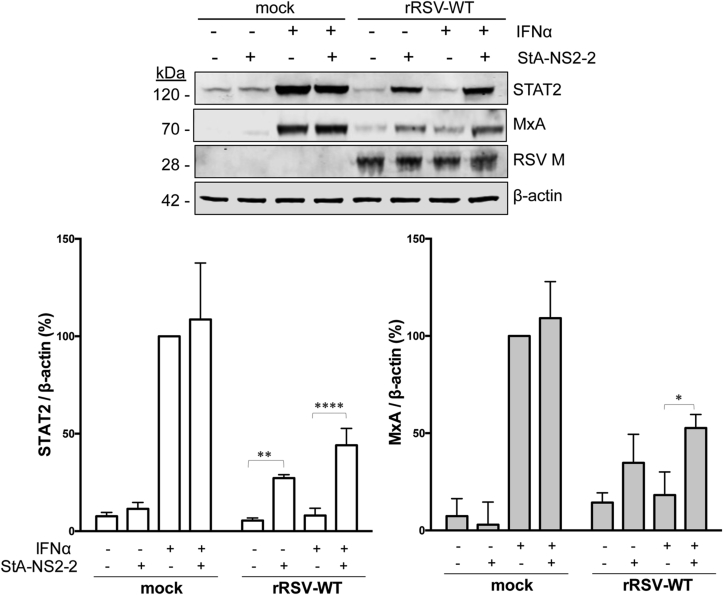
Effect of StA-NS2-2 in the context of rRSV-WT infection. Effect of StA-NS2-2 on MxA and STAT2 levels following infection of A549 cells with rRSV-WT. Infected cells were treated with StA-NS2-2 or the equivalent volume of DMSO. Six hours post-compound treatment, IFNα was used to activate the IFN signaling pathway. Twelve-hours post-IFNα treatment, cells were lysed, subjected to SDS-PAGE/Western blot, followed by detection with anti-STAT2, anti-MxA, anti-RSV-M or anti-actin antibody and IRDye680-or IRDye800-conjugated secondary antibody. Bands were visualized using an Odyssey near-infrared scanner, followed by quantification of % STAT2 and MxA levels relative to β-actin. Data shown represents mean values from 3 independent experiments; error bars = SD. Statistical significance was assessed using a one-way ANOVA with Tukey's multiple comparison test to compare effect of StA-NS2-2 on STAT2 and MxA levels in rRSV-WT infected cells; *, p < 0.05, **, p < 0.005, ****, p < 0.0001.